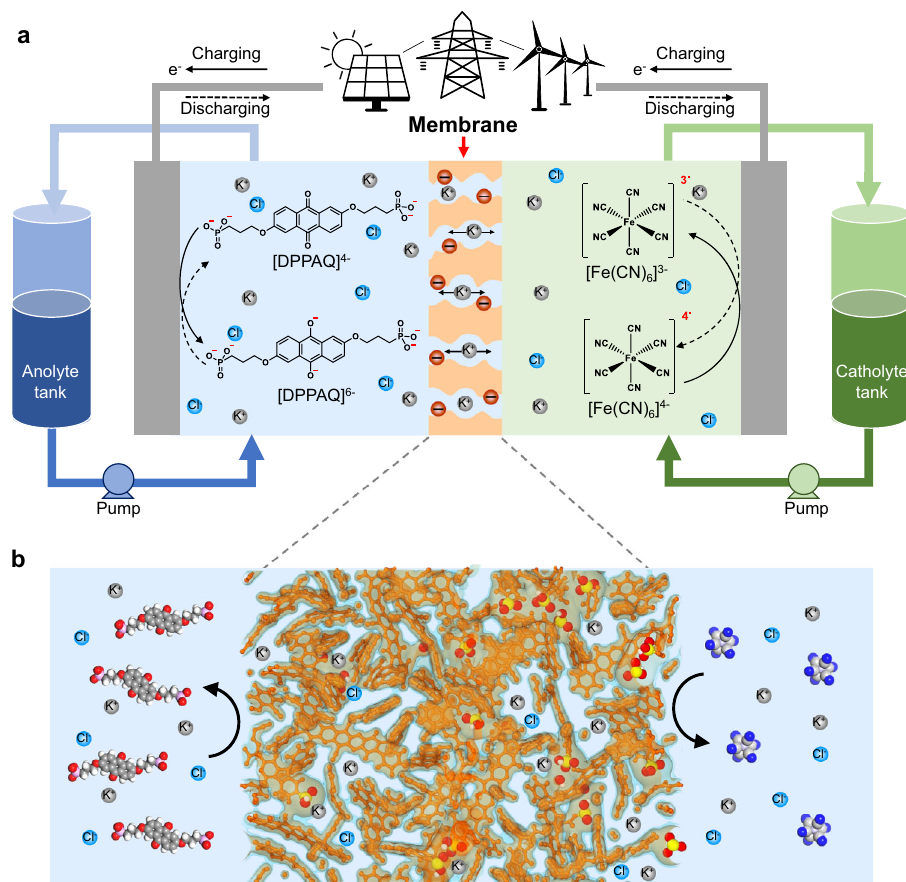
Fig. 1 Ion-selective membranes for aqueous organic redox fl ow batteries. a Schematics of an aqueous organic redox fl ow battery for grid-scale energy storage. Gray, blue and red spheres refer to K + , Cl − , and SO 3 − groups, respectively. b Schematic showing the polymer ion-sieving membrane with subnanometer-sized pores that enable fast transport of charge-carrying ions while limiting the crossover of redox active species. Sulfur and oxygen atoms are colored as yellow and red,